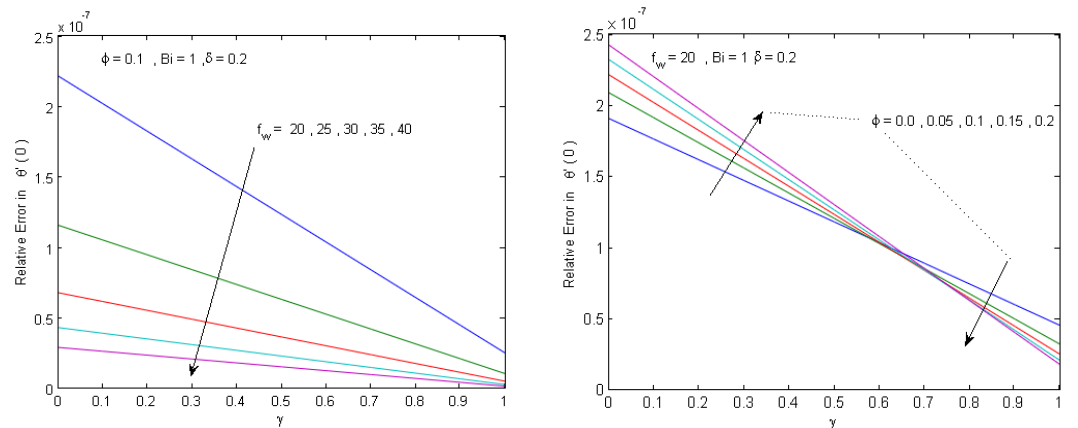
f , , Bi and on the maximum absolute error w (cid:48) ( η ) .